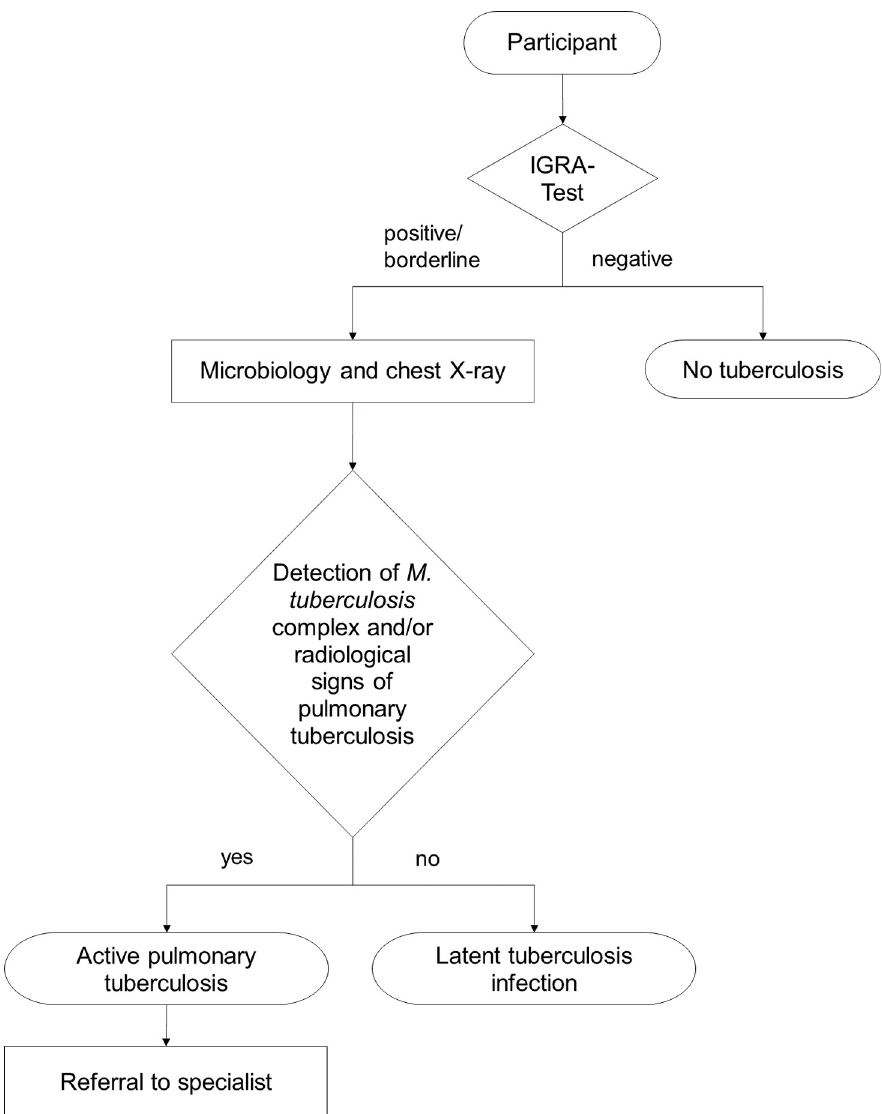
Fig 1. Diagnostic procedures to determine tuberculosis (TB) infections in participants. All Participants were tested by Interferon-gamma release assay (IGRA). Patients with borderline/positive IGRA results were screened for active pulmonary TB. Latent TB infection (LTBI) was defined as “a state of persistent immune response to stimulation by Mycobacterium tuberculosis antigens with no evidence of clinically manifest active TB” according to the World Health Organization [4].